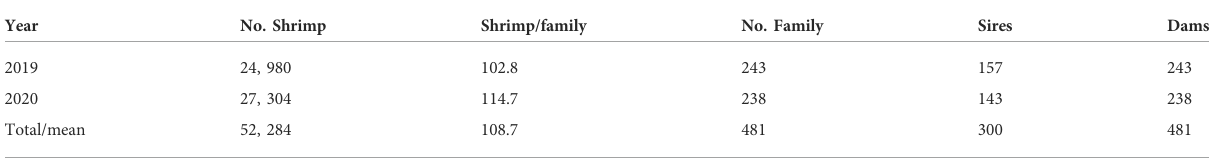
TABLE 1 Data structure of paci fi c white shrimp breeding nucleus